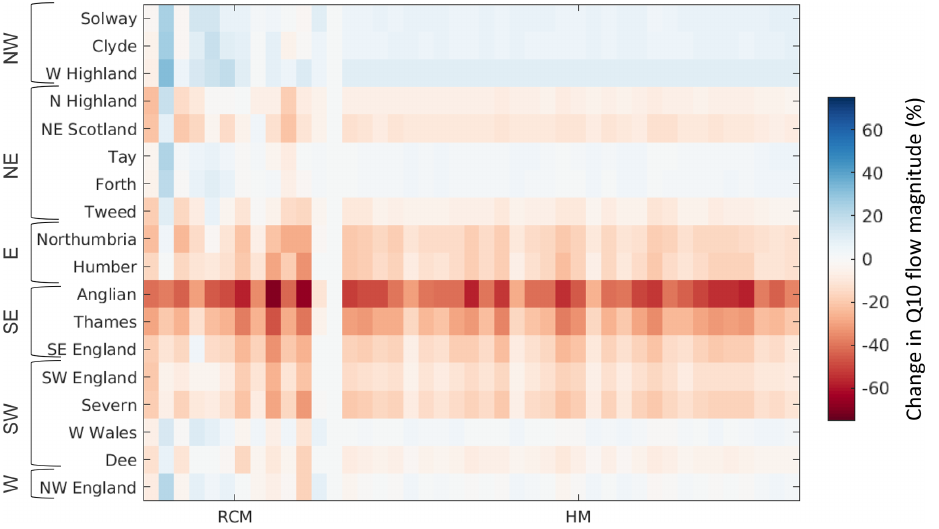
Figure 6. Heat map showing region-average changes in Q10 flow magnitude between the baseline and future periods. The 12 columns on the left focus on the difference between RCM parameterisations, using the median flow value from all hydrological model parameter sets. The 30 columns on the right focus on the difference between hydrological model parameterisations, using the median flow value from all RCMs. Regions have been ordered by location, with the relative position within GB given on the left.